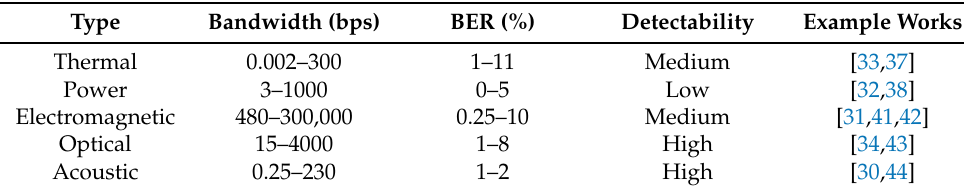
Table 1. Summary of characteristics of physical covert